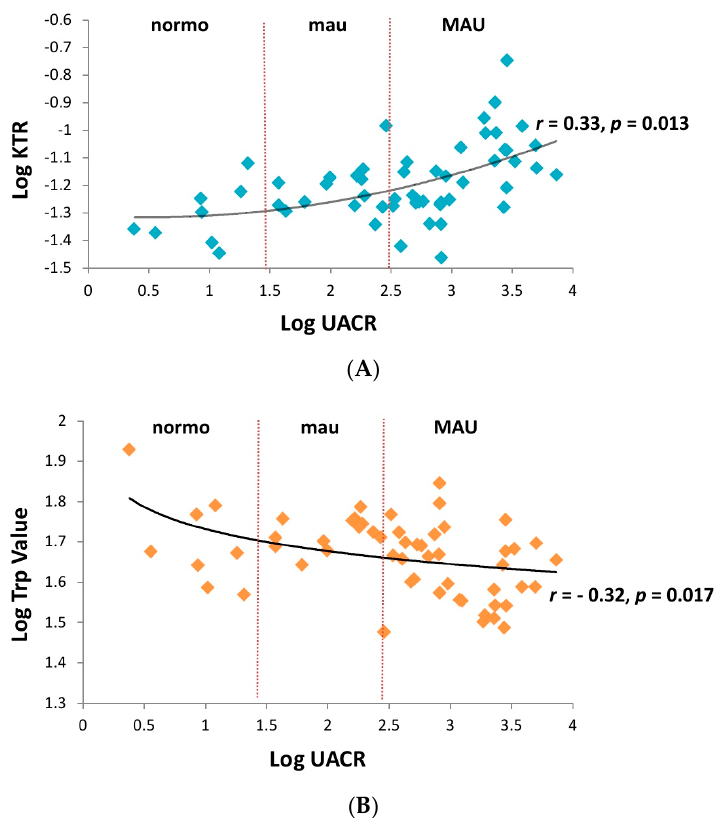
Figure 1. ( A ) The serum kynurenine/tryptophan ratio (KTR) revealed a significantly positive correlation with the severity of albuminuria ( r = 0.33, p = 0.013). ( B ) Serum trptophan (Trp) showed a significantly negative correlation with the severity of albuminuria ( r = − 0.32, p = 0.017). MAU, macroalbuminuria; mau, microalbuminuria; normo, normoalbuminuria.